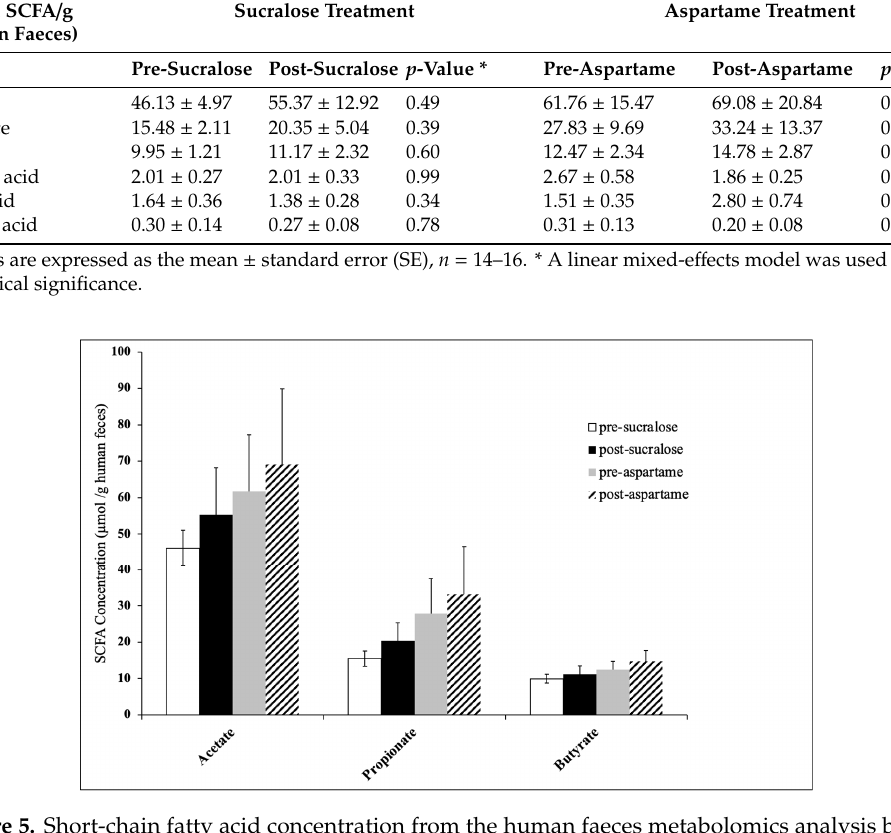
Table 6. Short chain fatty acid (SCFA) concentration (mmol SCFA/kg human faeces) from the metabolomics analysis in healthy participants. SCFA Concentration ( µmol SCFA/g Human Faeces )